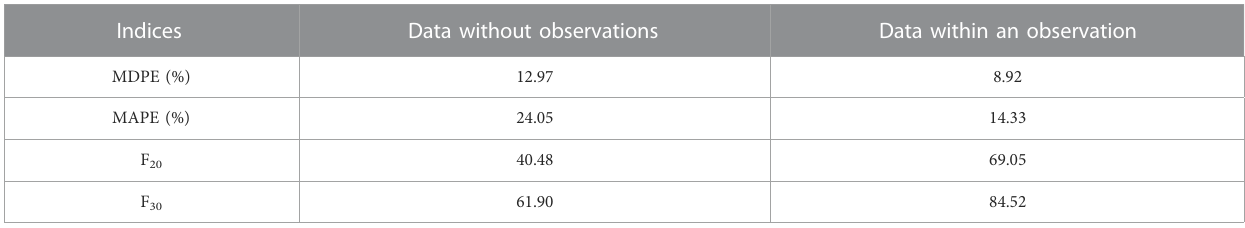
TABLE 5 External validate results of nalbuphine PopPK